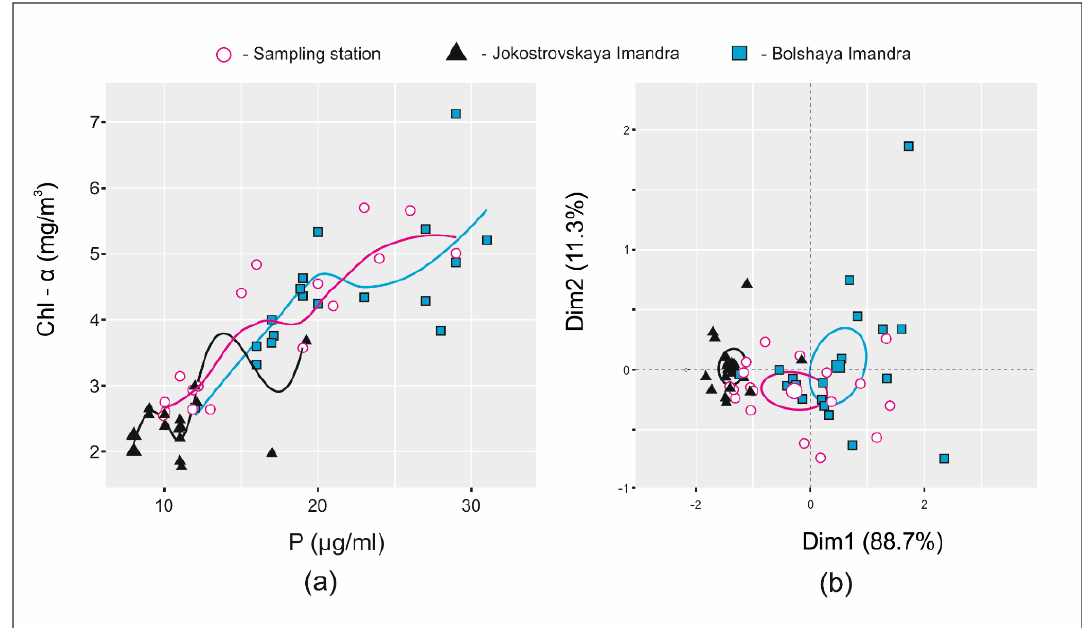
Figure 5. LOESS local regression analysis ( a ) and PCA ( b ) of the associations between total phosphorous and chlorophyll-a concentrations in Bolshaya Imandra, Jokostrovskaya Imandra, and sampling site areas located at the intersection of the two most eutrophic parts of the lake.